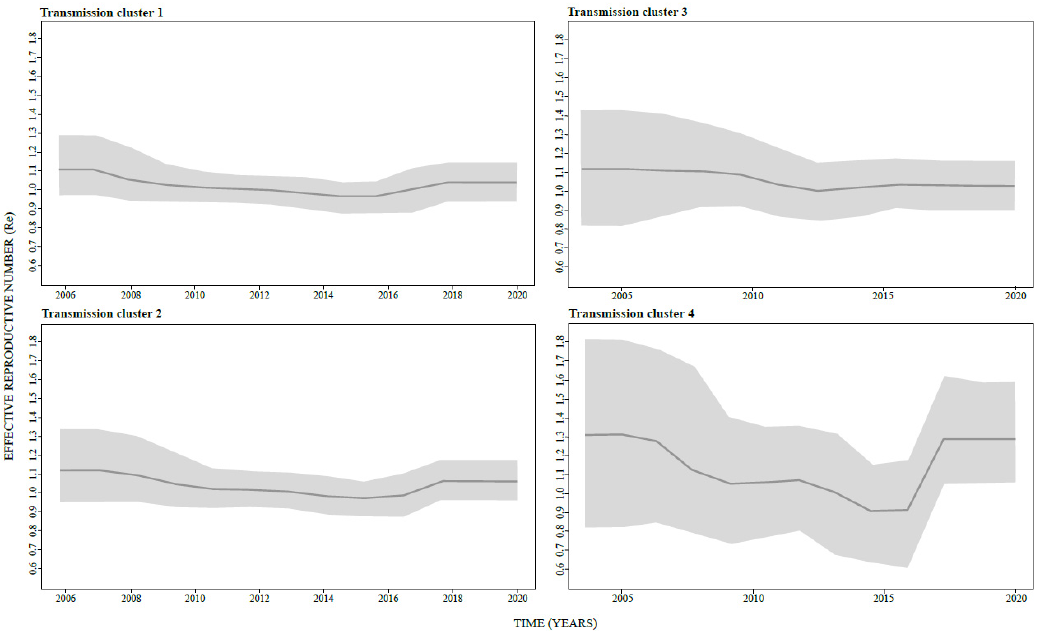
Figure 4. Effective reproductive number of four large transmission clusters (>10 sequences) obtained by birth death skyline analysis performed in BEAST 2 software under the following parameters; relaxed lognormal clock, birth death skyline serial prior, reproductive number with five dimensions. Re plot was obtained in R software under the bdskytool software package.